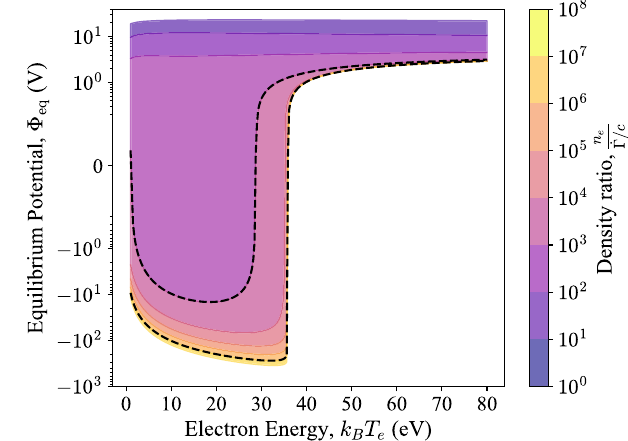
FIG. 5. Equilibrium potential of a Cu grain as a function of the energy of the incoming electrons. The color gradient shows the results for several density ratios. The black dashed lines identify the region corresponding to LHC conditions.